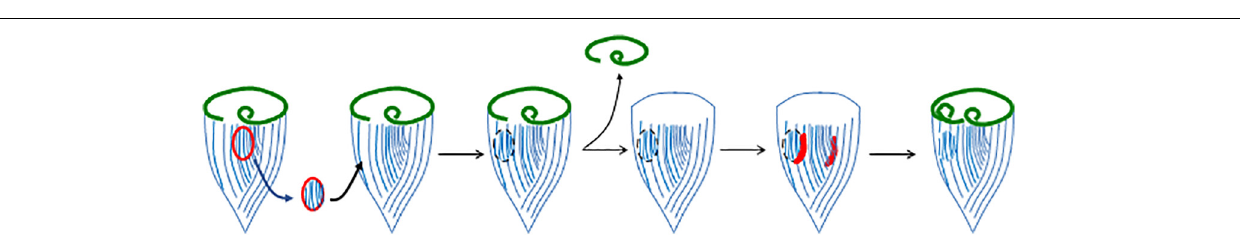
FIGURE 3 | Induction of a new oral primordium by juxtaposition of narrow and wide striped cortical regions. In this experiment, a region of the cortex containing narrow stripes (closely spaced ciliary rows), but not including the locus of stripe contrast itself, is removed from one cell and grafted onto another in a region containing wider stripes. When the graft recipient cell is induced to regenerate, the new contrast zone supports the formation of a second oral